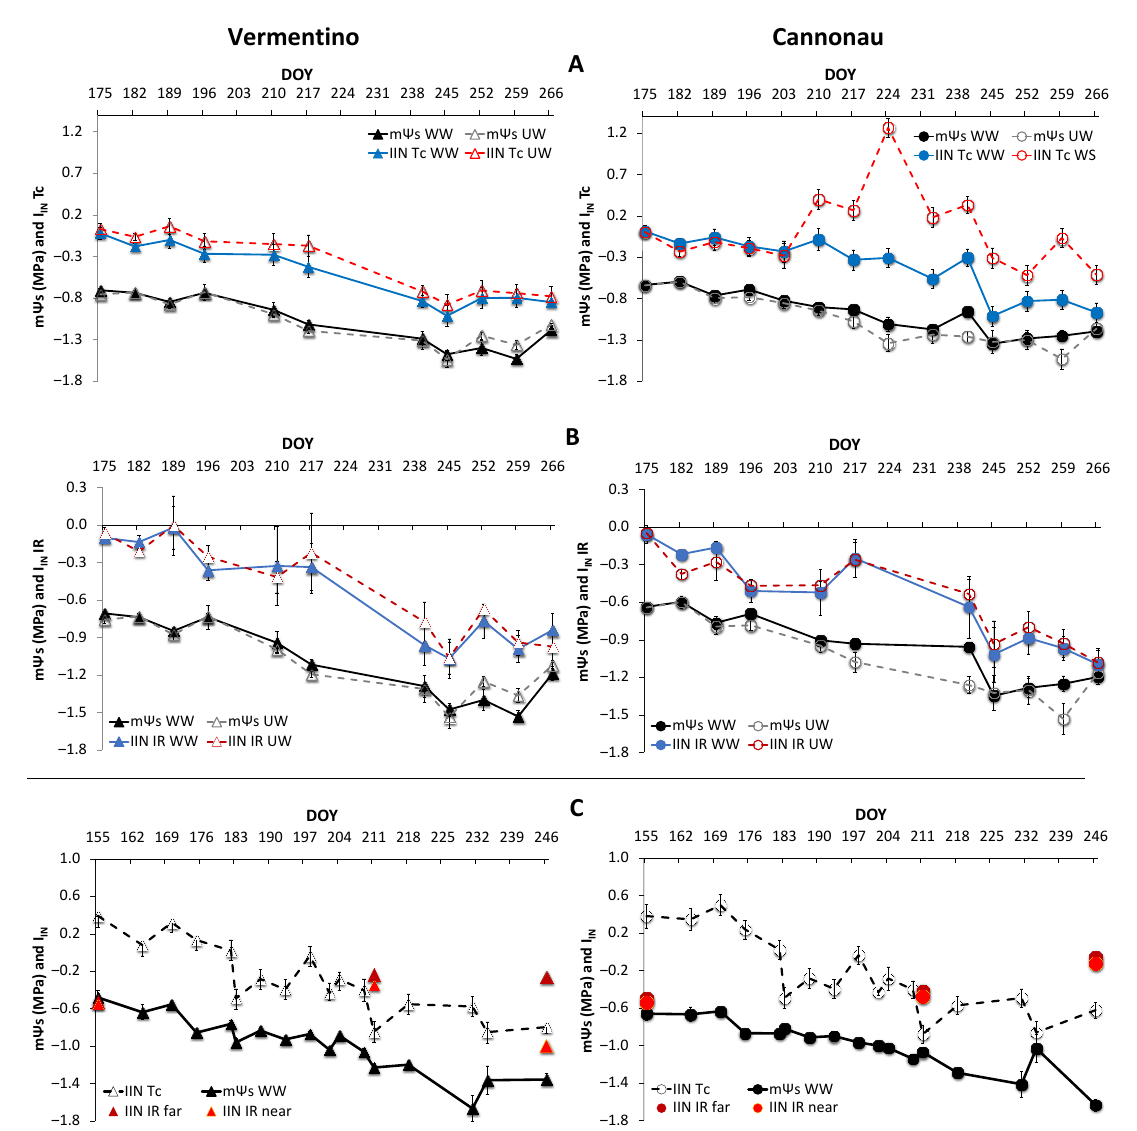
Figure 6. Weekly pattern of m Ψ and of I IN , in re-watered (WW) and un-watered (UW) treatments, in Vermentino and Cannonau vineyards from Romangia in 2019 ( A , B ); and Gallura in 2020 ( C ). I IN calculated on the basis of leaf temperatures estimated by thermistors, I IN Tc ( A ); and on the basis of canopy temperature measured with IR thermometer, I IN IR ( B ); Values are mean ± standard error.